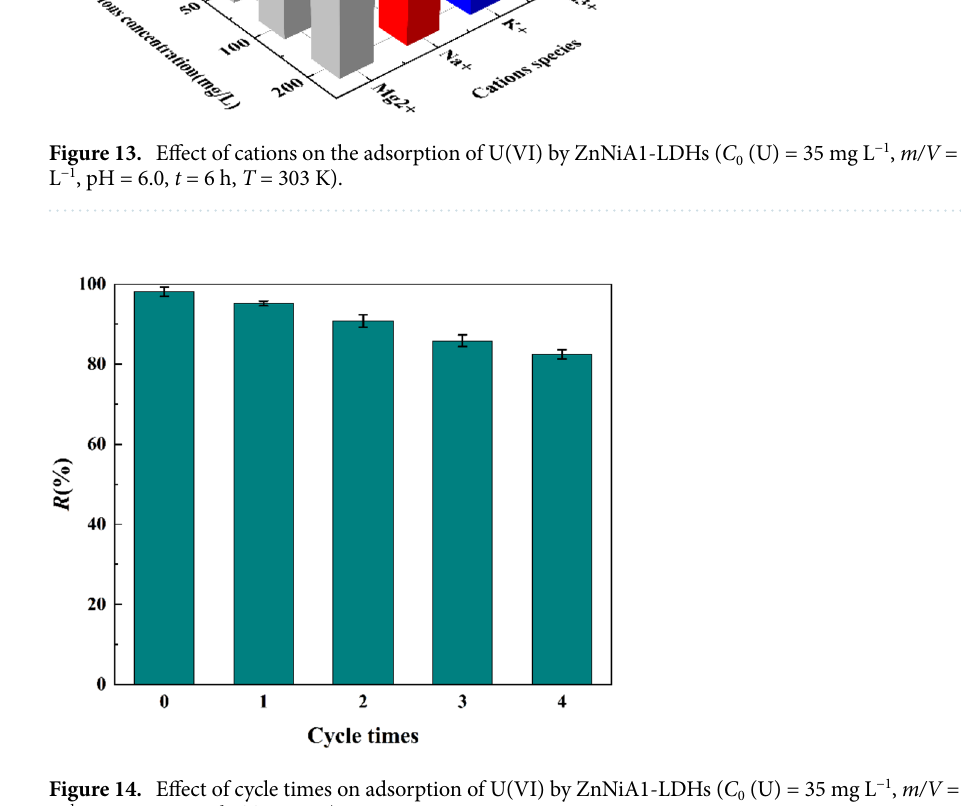
Figure 14. Effect of cycle times on adsorption of U(VI) by ZnNiA1-LDHs ( C 0 (U) = 35 mg L −1 , m/V = 0.125 g L −1 , pH = 6.0, t = 6 h, T = 303